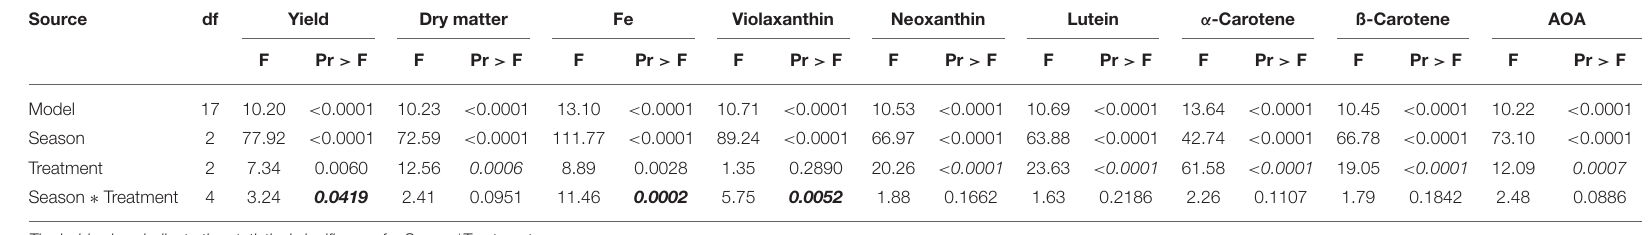
The bold values indicate the statistical significance for Season * Treatment. TABLE 2 | Analyses for marketable yield and nutritional content of red amaranth under colored poly-net house, white poly-net house, and open field conditions in Taiwan during 2020–2021. Source